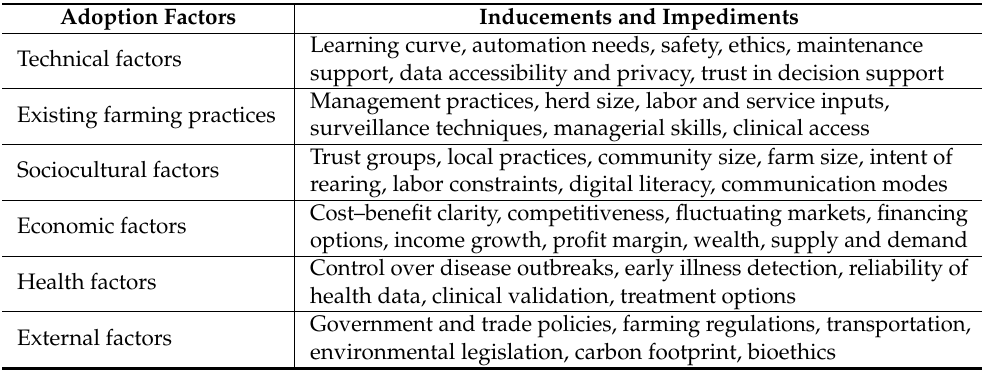
Table 3. Perceived inducements and impediments in the adoption of ear tag sensor boards by pig